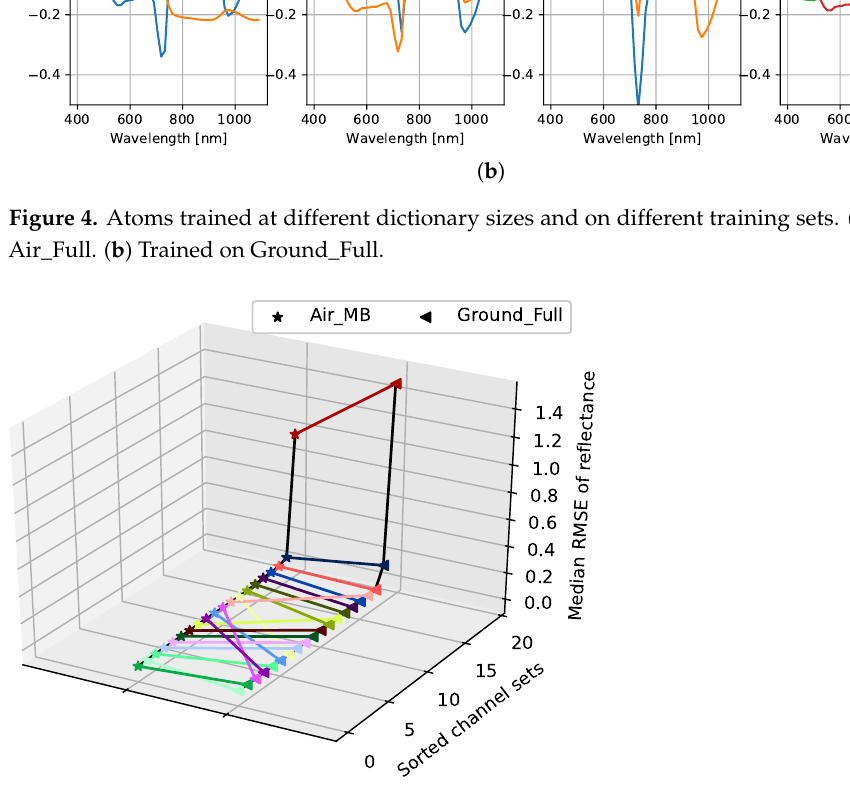
Figure 5. Applicability of band selection between datasets. Training was performed on dataset Air_MA